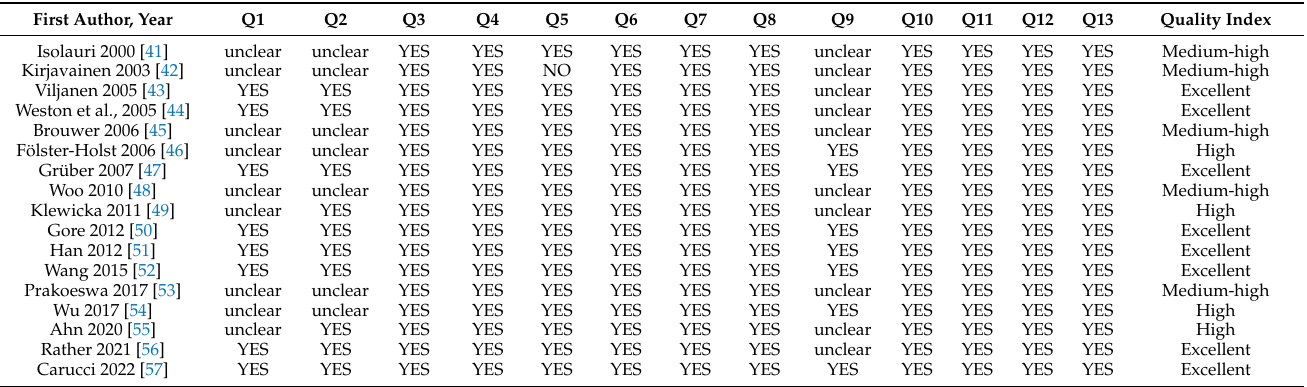
Table 1. The quality assessment checklist of the 17 included clinical trials using the Joanna Briggs Institute critical appraisal tool for randomized controlled